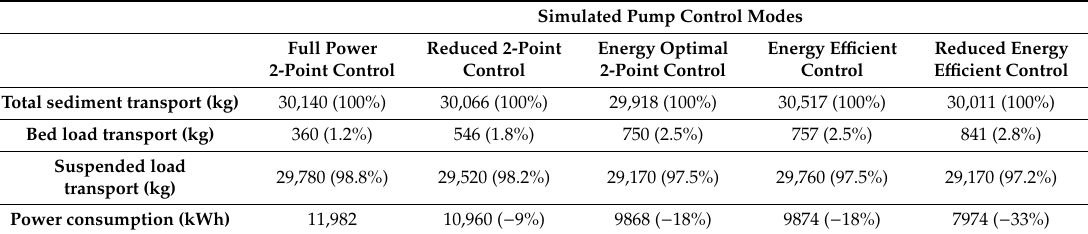
Table 2. Resulting bed and suspended load for five di ff erent pumping